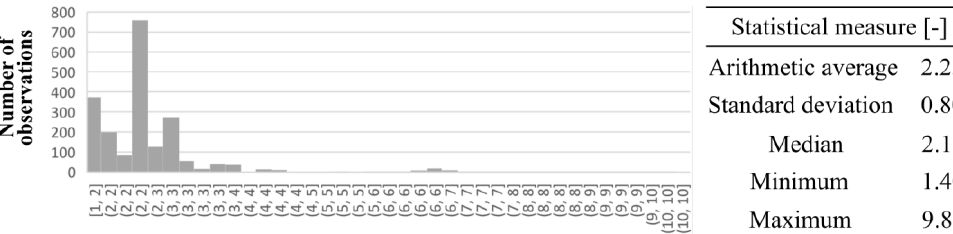
Figure 19. The HDOP geometric index along the test route.